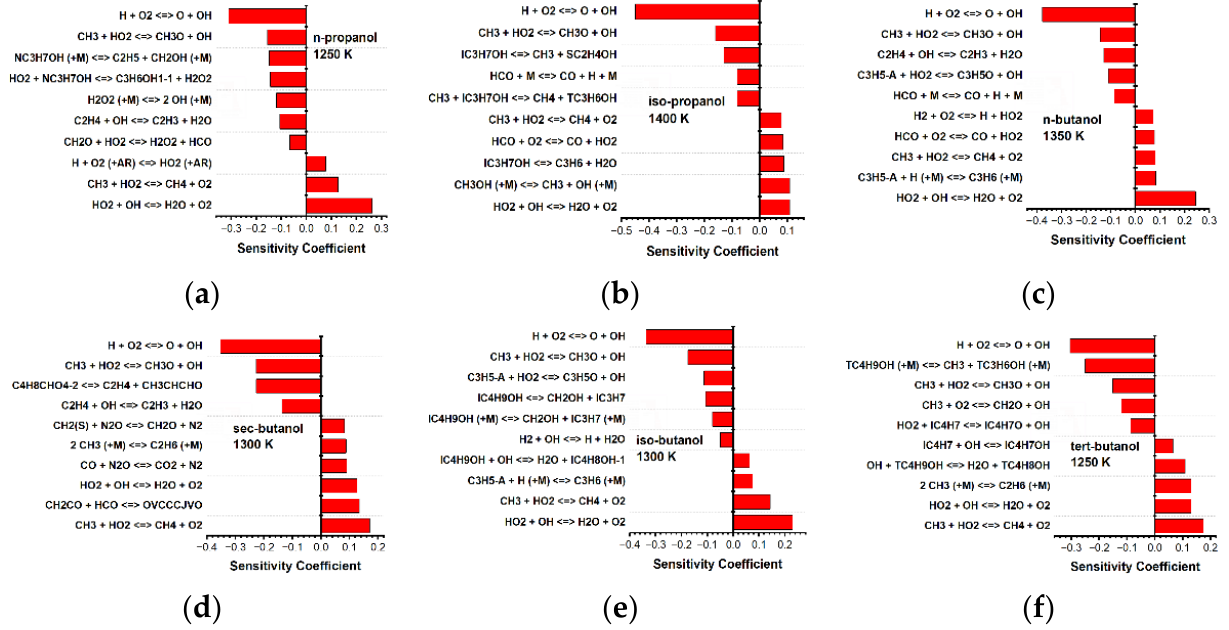
Figure 5. Sensitivity coefficients of the IDT at 10 bar and ϕ = 0.25 based on the C4 mechanism with 3402 reactions for ( a ) n-propanol at 1250 K, ( b ) iso-propanol at 1400 K, ( c ) n-butanol at 1350 K, ( d ) sec-butanol at 1300 K, ( e ) iso-butanol at 1300 K, ( f ) tert-butanol at 1250 K.